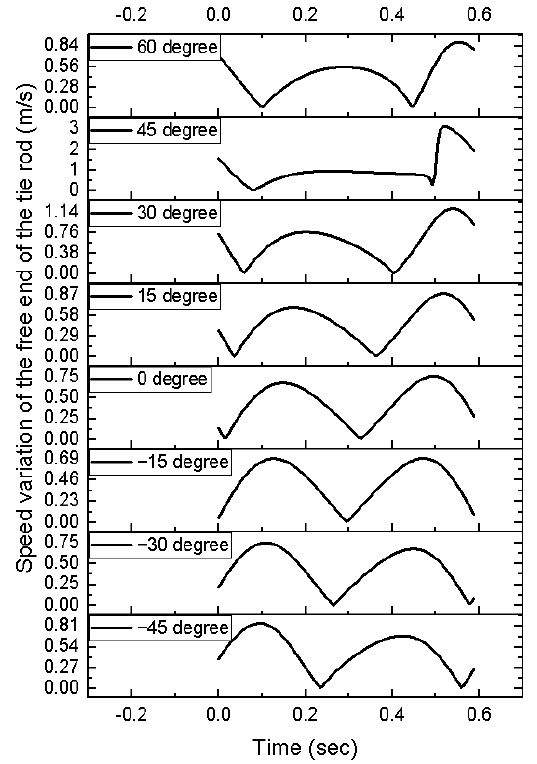
found that the angle ψ increased in value, reaching a maximum of 32° for the angle β = − 45°.